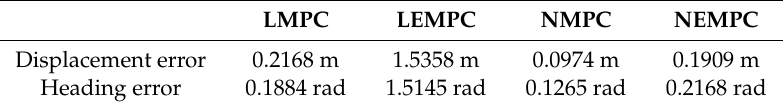
Table 3. The maximum absolute values when velocity is 3 m /